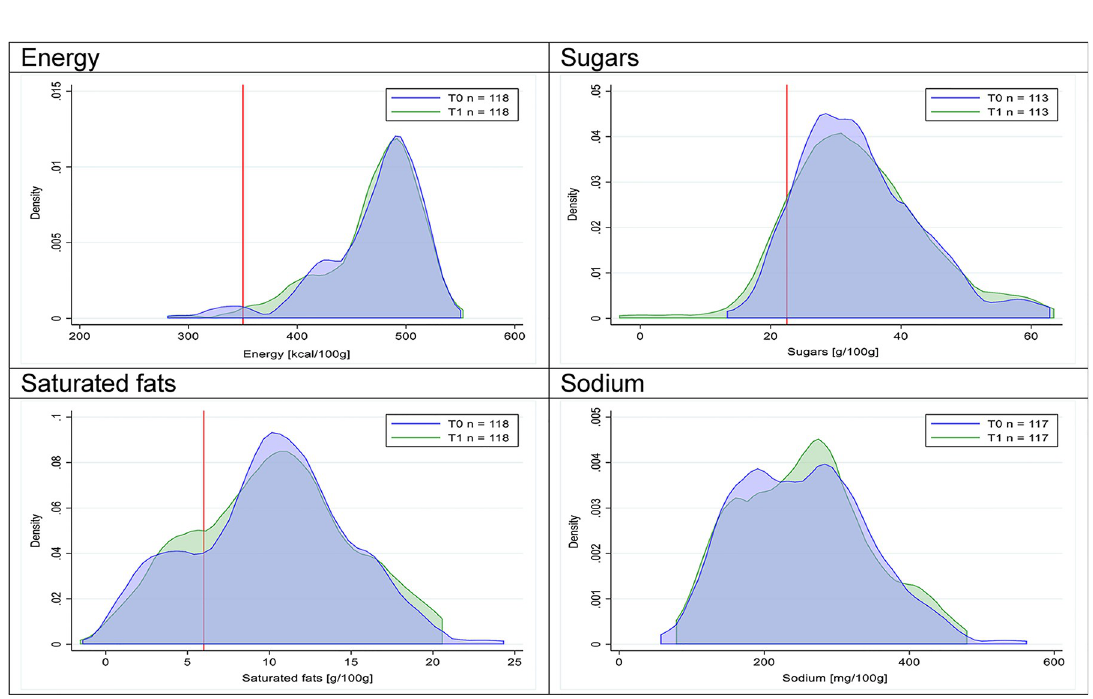
Fig 22. Density curves for the amount of energy and nutrients of concern in sweet baked products, longitudinal subsample. The blue line represents the distribution in T0 (preimplementation), the green line represents the distribution in T1 (postimplementation), and the red line represents the cutoff for the amount of energy or nutrients of